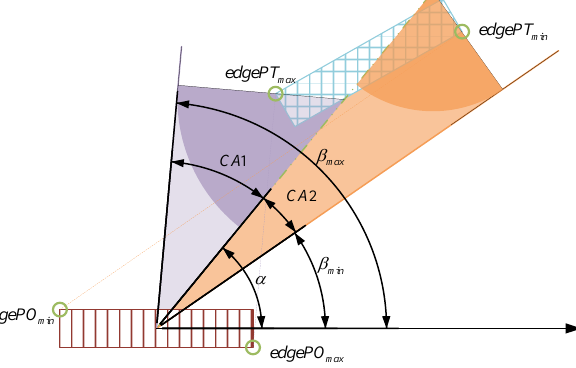
Figure 5. Velocity obstacle cone of the target ship in polar coordinates. Algorithm 1. Algorithm for selecting critical collision points by slope (where, Input is the vertex of our ship and the target ship, and the number of vertices of the polygon; PT ( 2 ) represents the ordinate of the vertex of the target ship; CWO 90 and CCWO 90 are subfunctions that rotate the point 90 ◦ clockwise and 90 ◦ counterclockwise about the origin, respectively; K is a one dimensional vector that stores all slopes; indexMax and indexMin are the subfunctions to obtain the maximum and minimum position indices, respectively; and R ound is the downward rounding